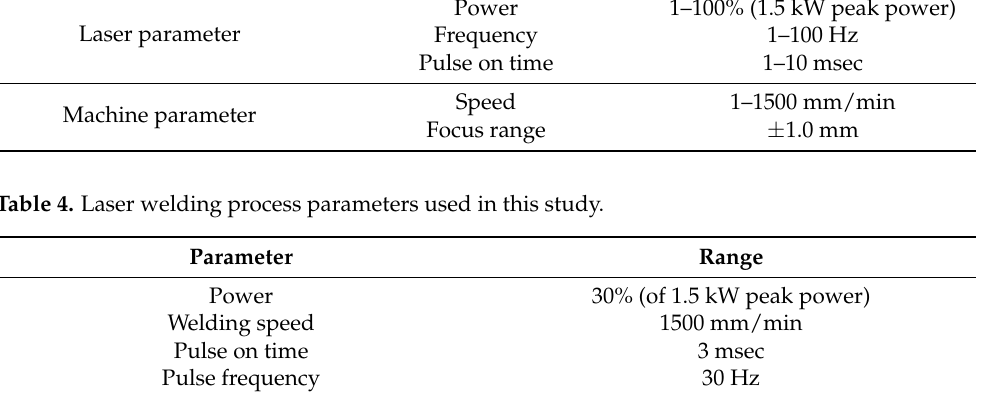
Table 4. Laser welding process parameters used in this study.